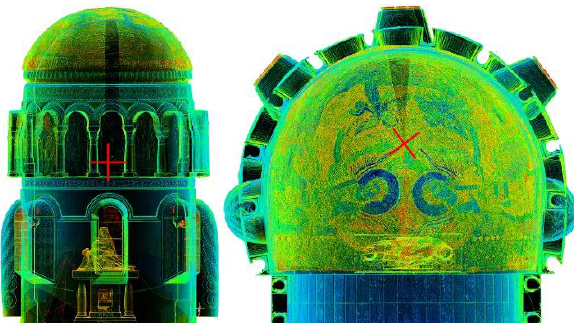
Figure 2 Top View and Side view of TLS data, with the optical TLS centre’s position (red